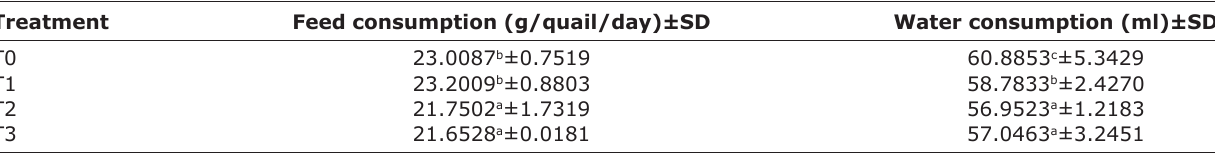
Table-1: Feed consumption and water consumption of quail in 4 weeks of treatment. Treatment